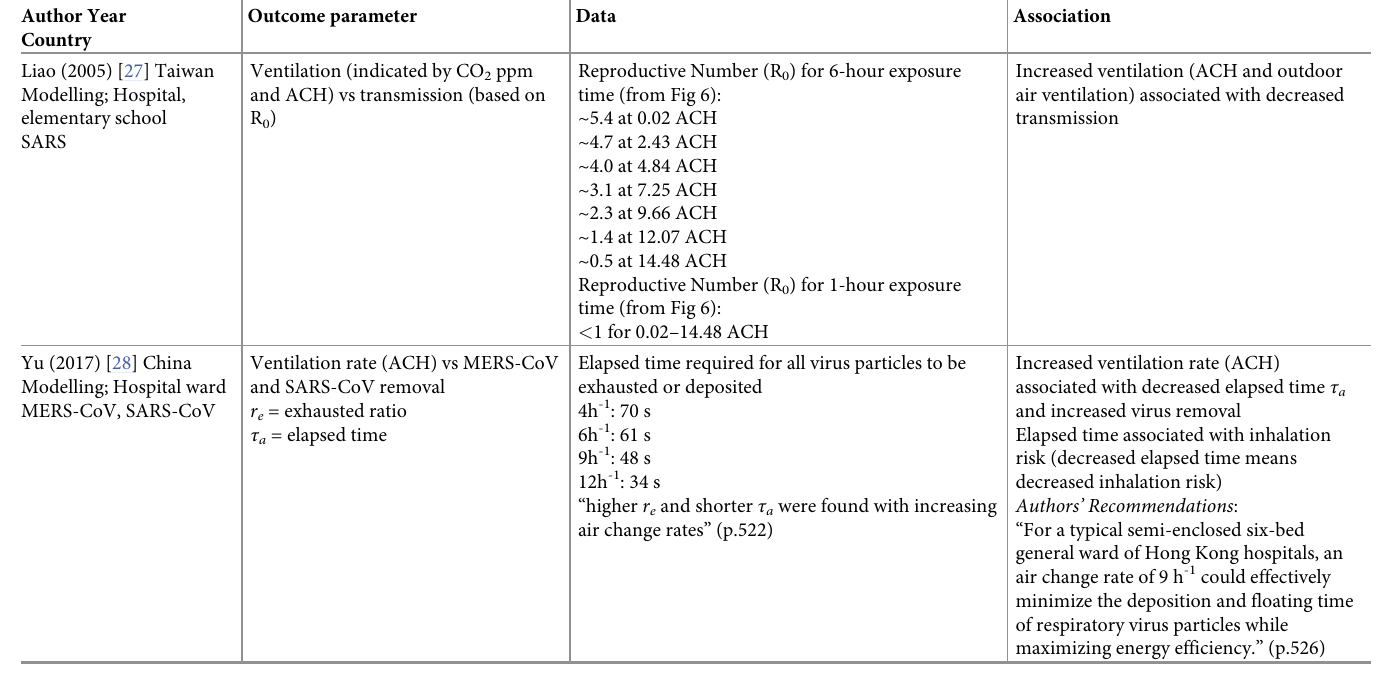
Table 3. Characteristics and results of studies examining ventilation rate and coronavirus transmission. Author Year Outcome parameter Country